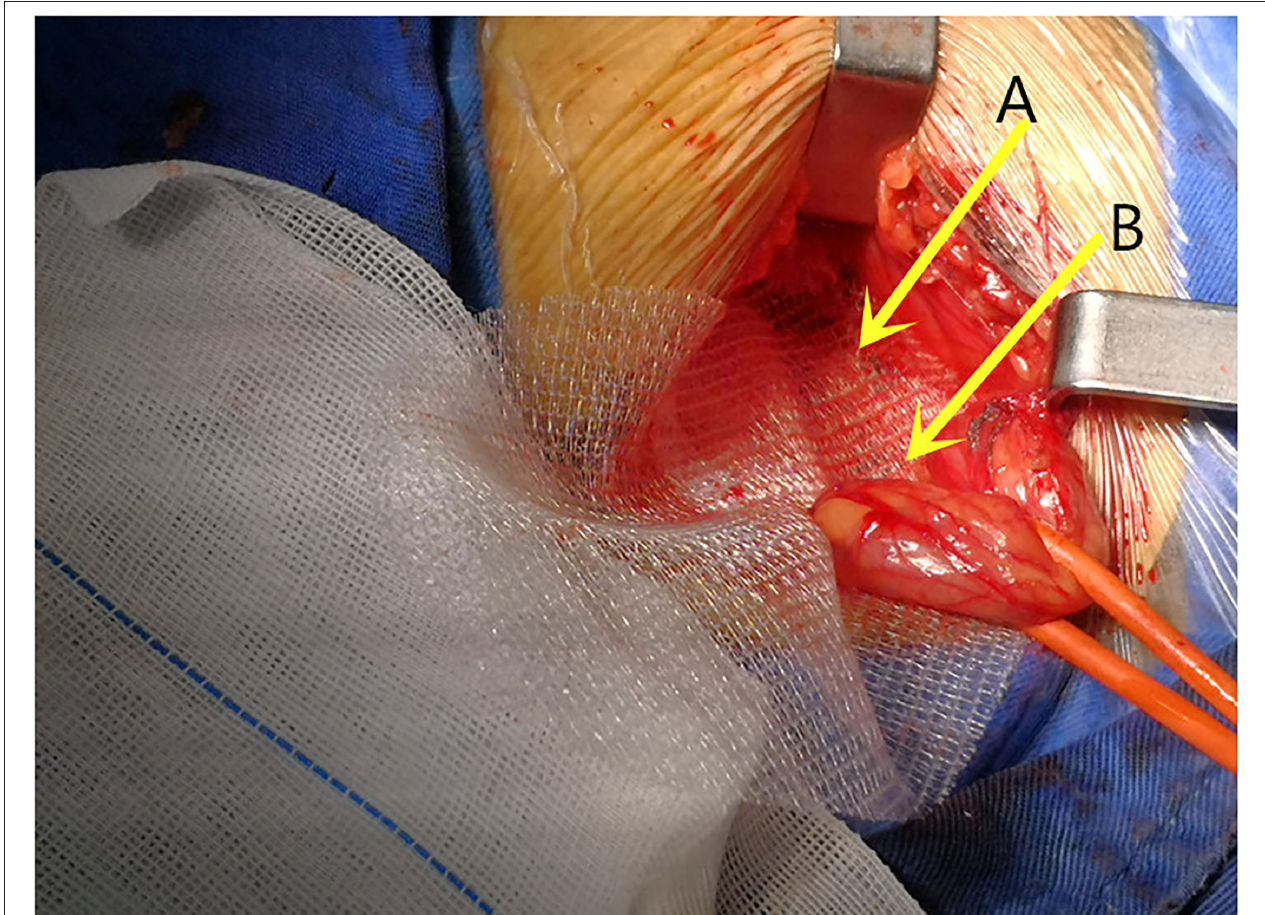
FIGURE 1 | The posterior rectus sheath and pubic tubercle were exposed and the mesh was placed beneath (A) the posterior rectus sheath and (B) cover the pubic tubercle.